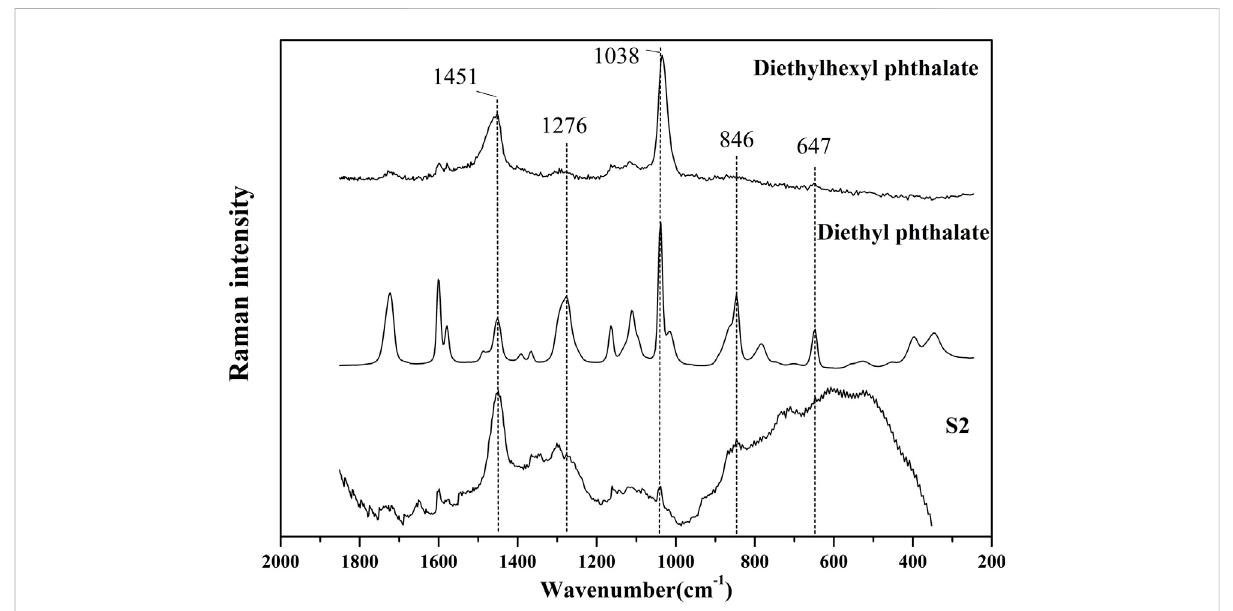
FIGURE 7 Comparison of Raman spectrums of S2 (adulterated sample) and diethyl phthalate, diethylhexyl phthalate (standard reference material of